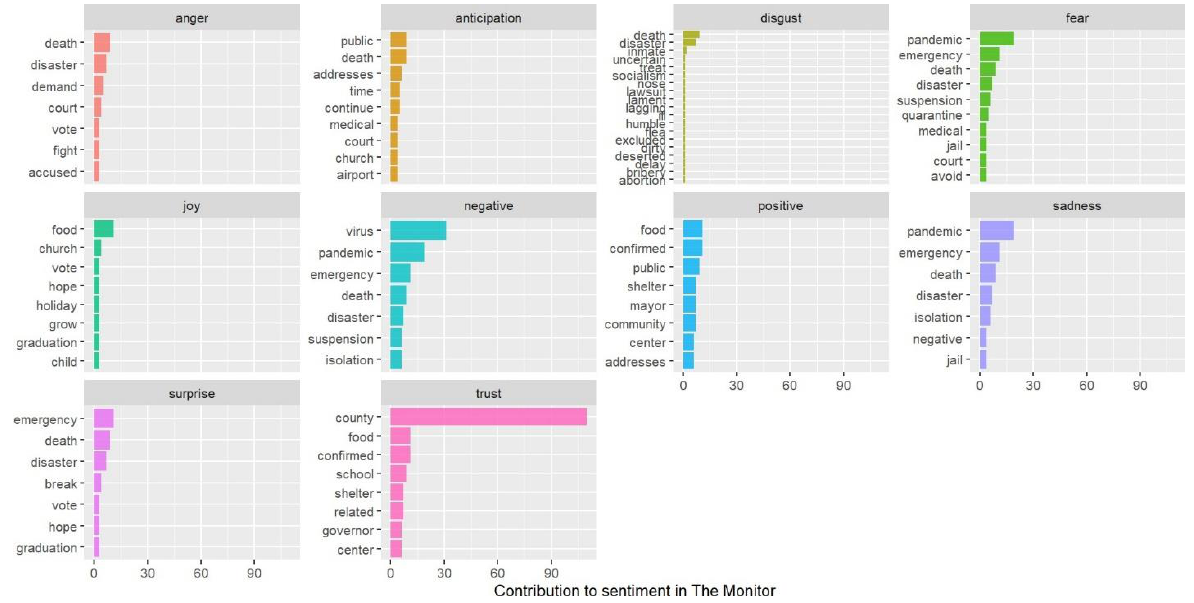
Figure 13. Top word distributions for each emotional valence (The Monitor).